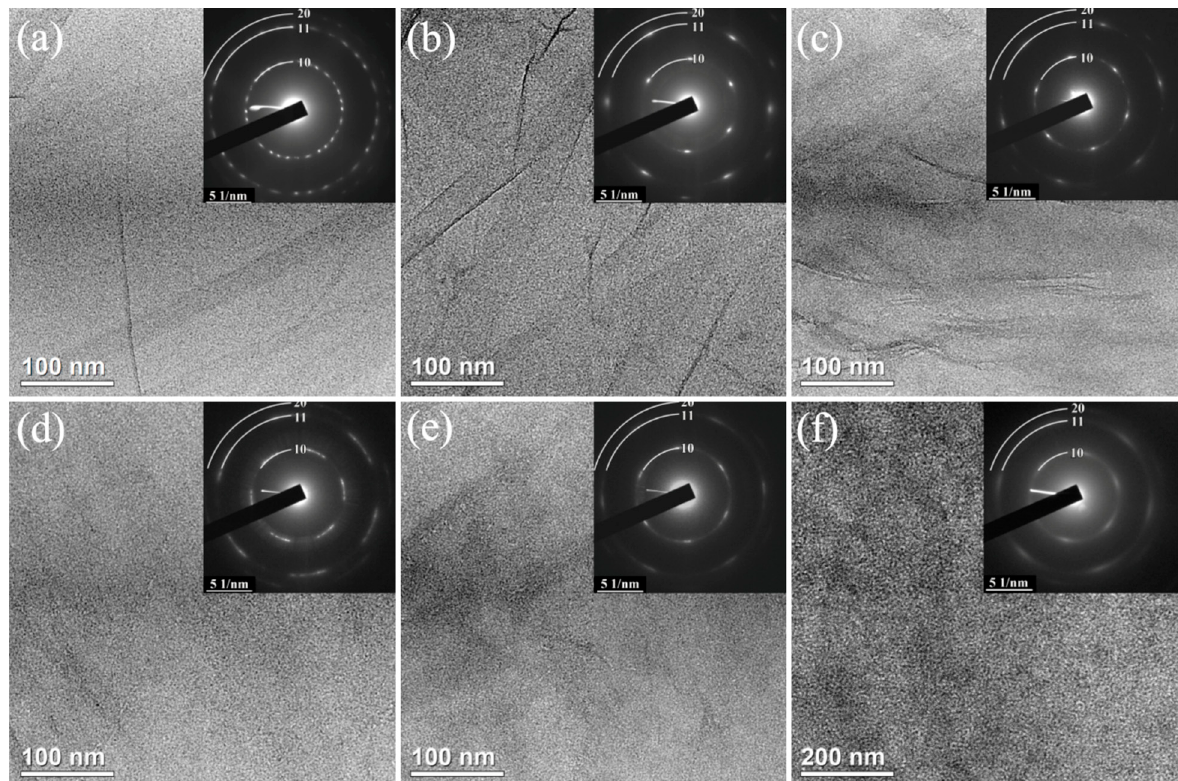
Figure 7. ( a – f ) TEM images and corresponding SAED patterns (insets) of the MC#1–MC#6 samples, respectively. The SAED patterns were acquired using a selective aperture with an 100 nm effective diameter.